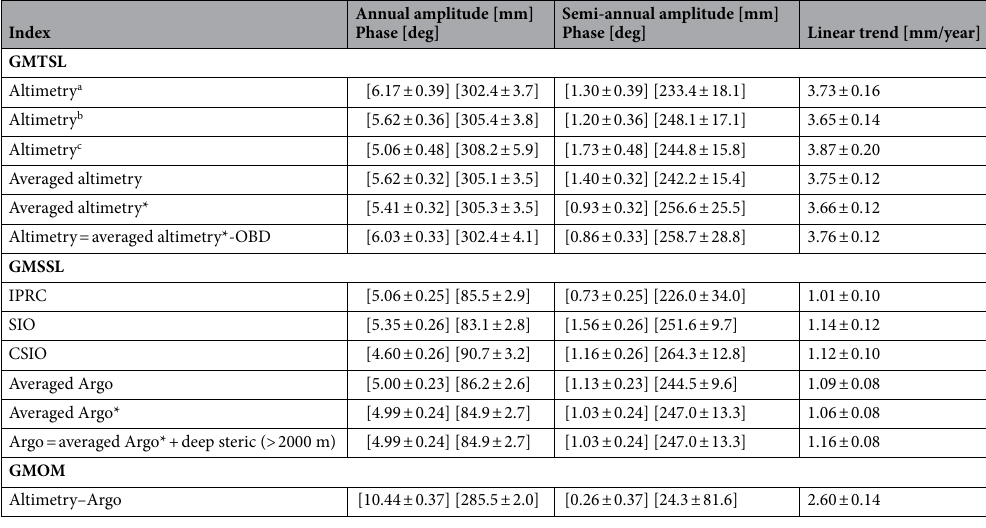
Table 2. Amplitudes of annual and semiannual components and linear trends of global mean sea-level change from Altimetry and Argo observations for the period January 2005 to December 2016. The uncertainty represents the least-squares fitting error (1 sigma for amplitudes and phases and 2 sigmas for trends). Same missing months are deleted from Altimetry and Argo data, the corresponding re-estimated results are given as